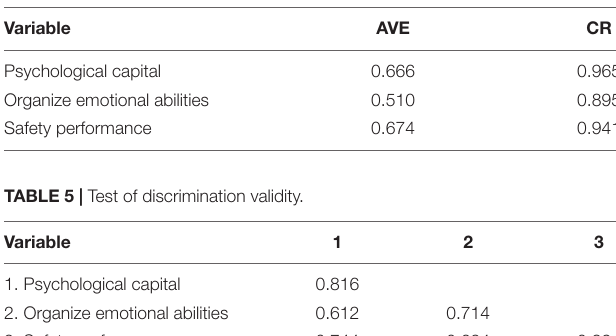
TABLE 4 | Test of convergent validity test.